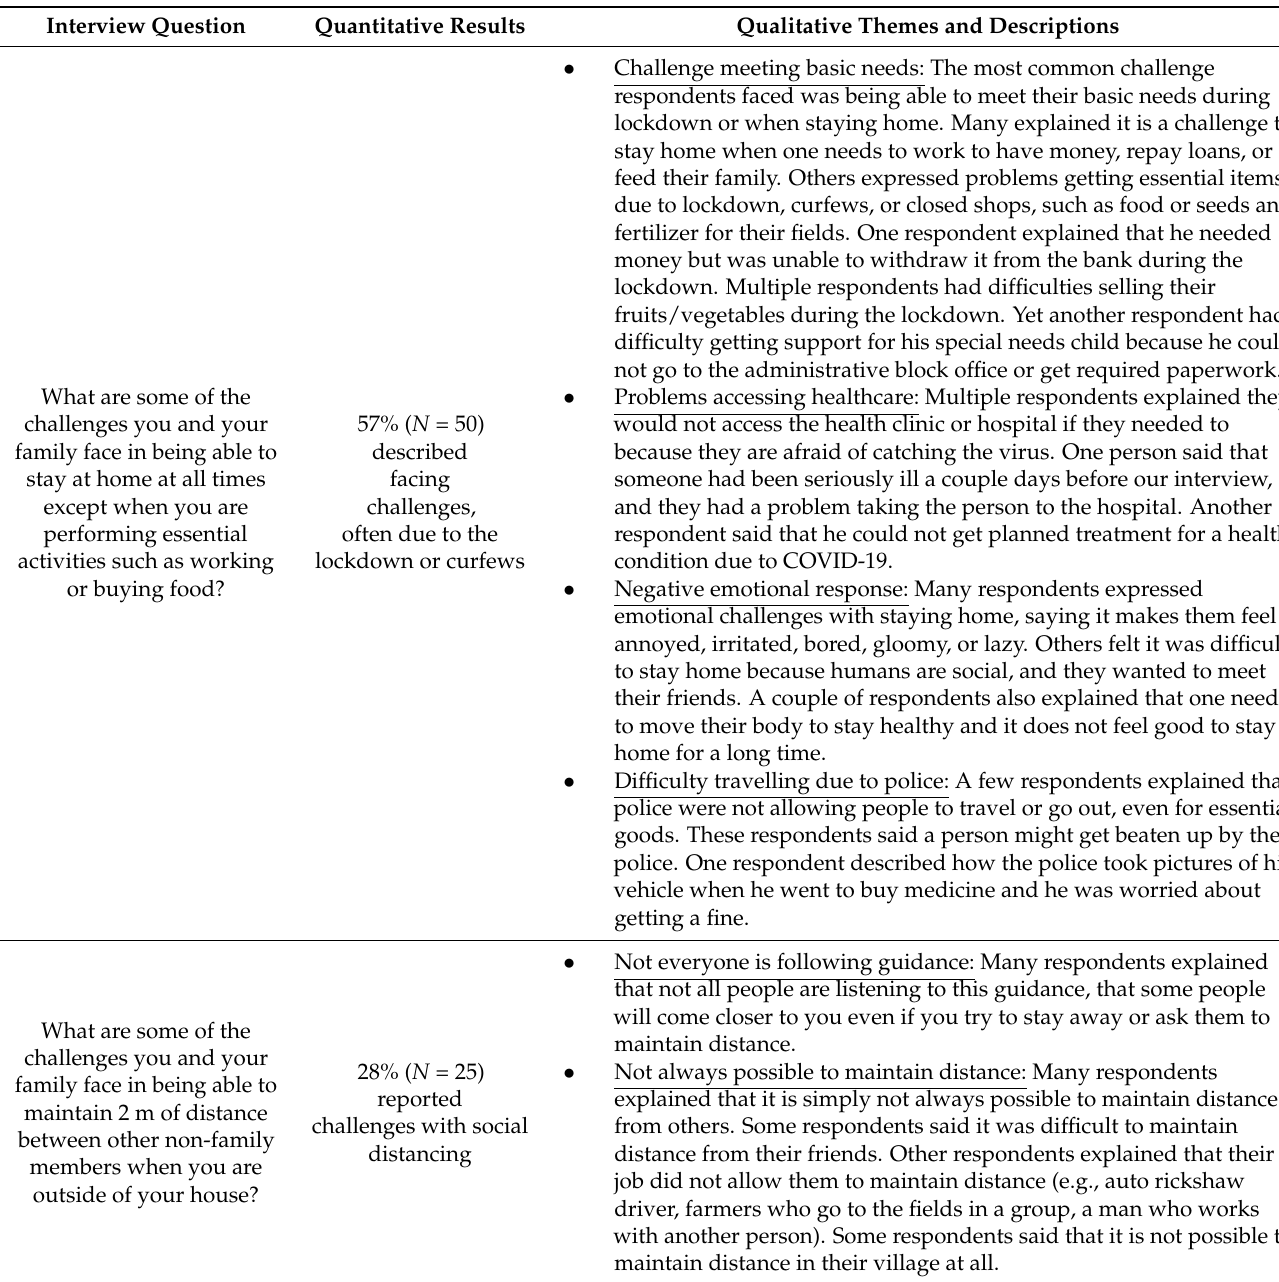
Table 3. Reported challenges related to following COVID-19 precautions of staying home as much as possible and social